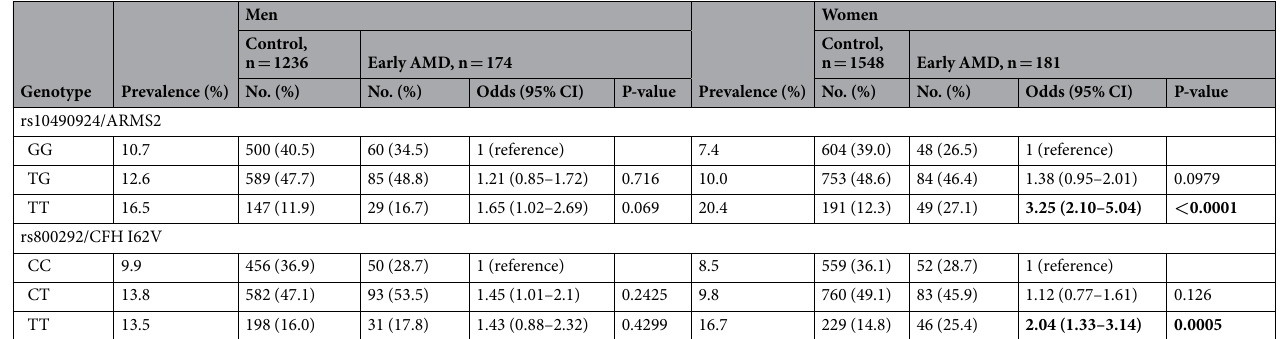
Table 4. Genetic risk for early AMD according to sex. Adjusted for age; Significant values are in